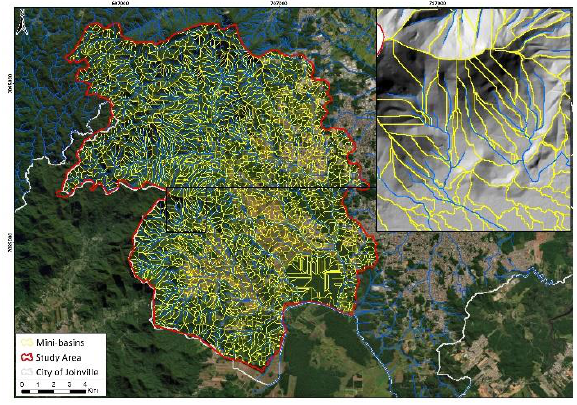
Figure 2: Mini-basins and hydrography of the study